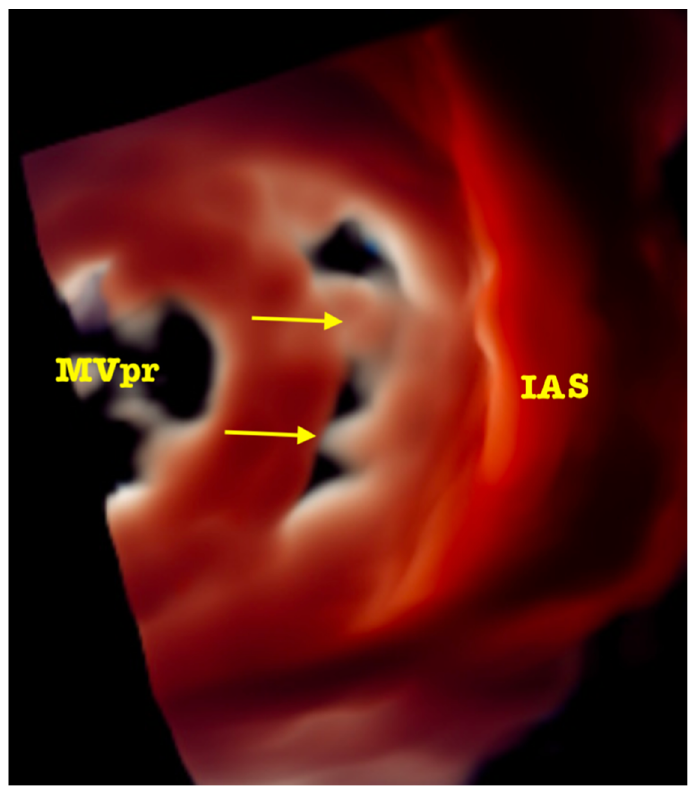
Figure 2. Advanced 3D image rendering with artificial “source of light” placed in the LV cavity allowing the precise visualization of the septa (arrows) dividing the PVL lumen (MVpr—mitral bioprosthesis, IAS—interatrial septum).